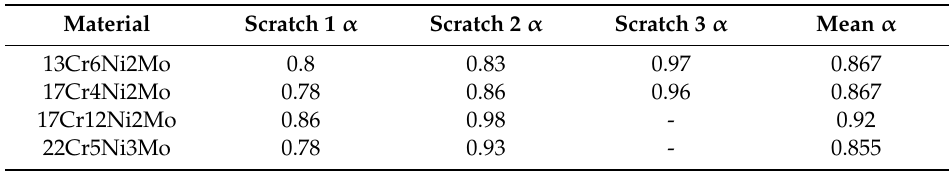
Table 4. α Values obtained from scratch tests in the linear regime found in log(i) vs. log(t) diagrams, between times t = 0.1 s and t = 1